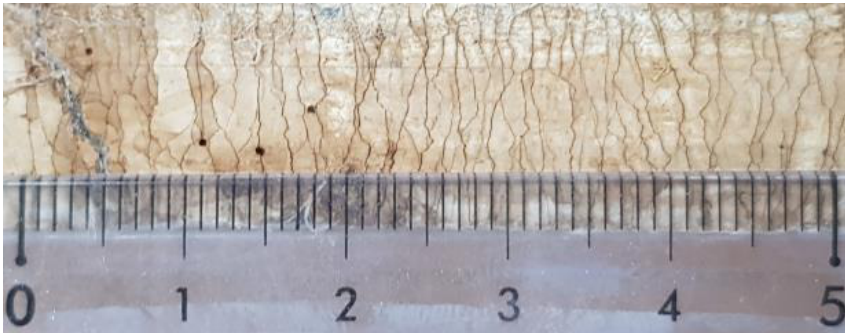
Figure 5. Cracking pattern of uniaxial tension test specimen (unit of number: cm).